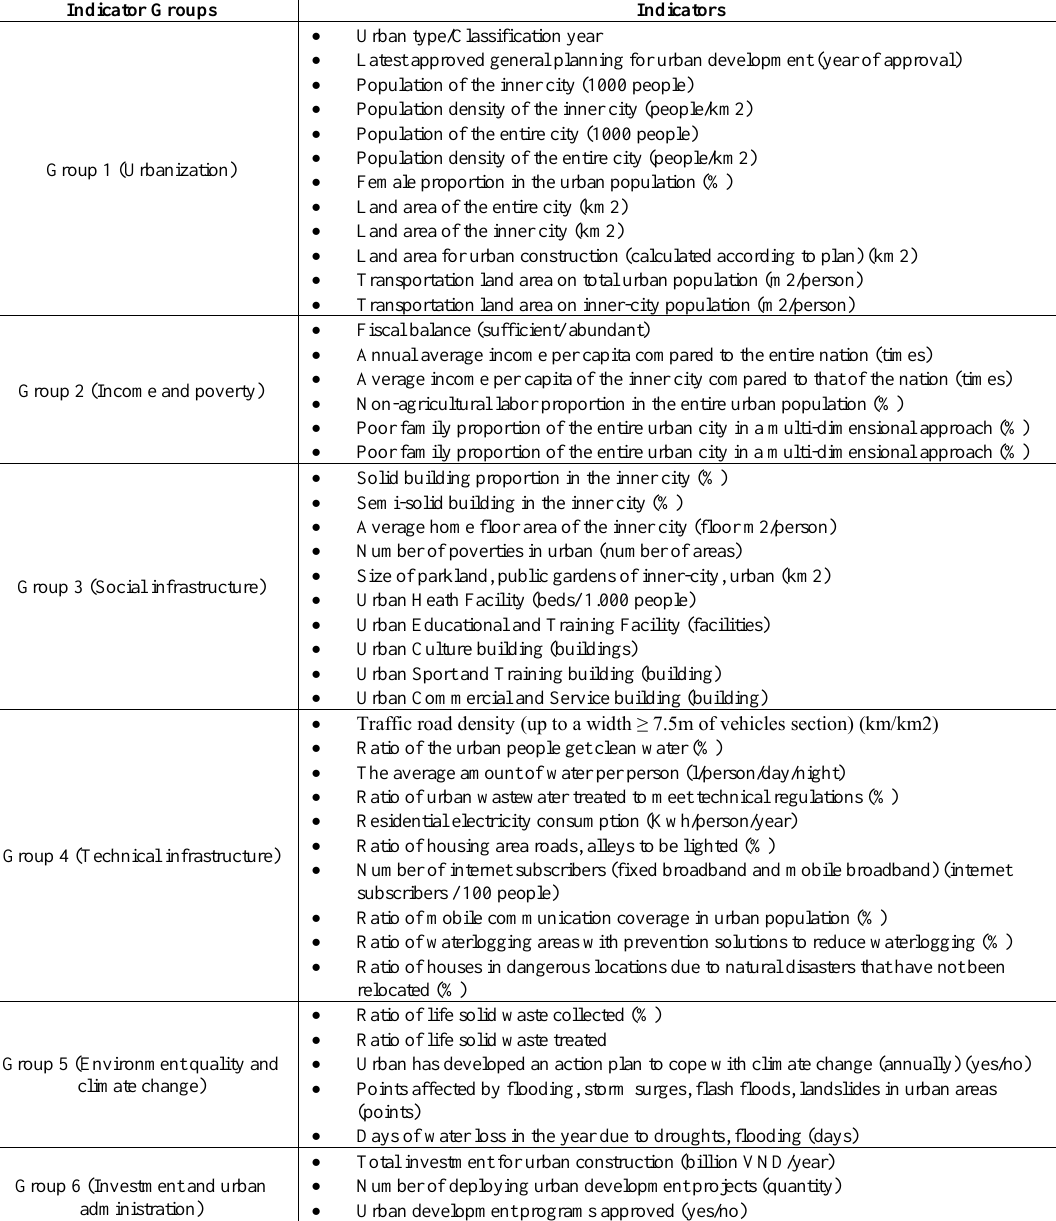
Table 15. The list of national urban development database